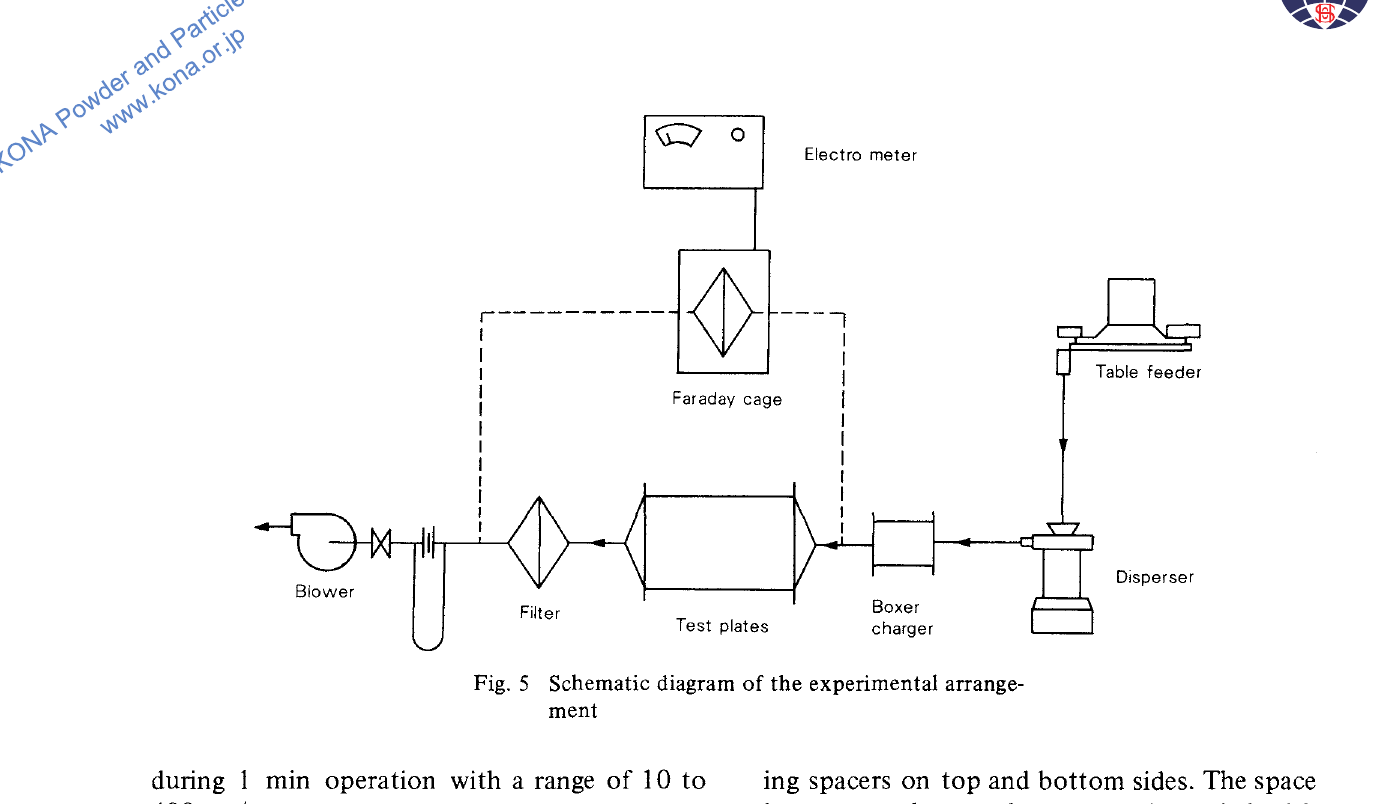
Fig. 5 Schematic diagram of the experimental arrange ment